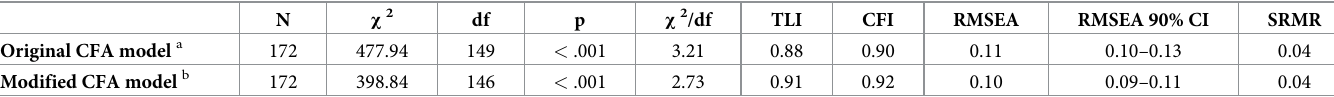
Table 2. Global fit indices of confirmatory factor analysis.